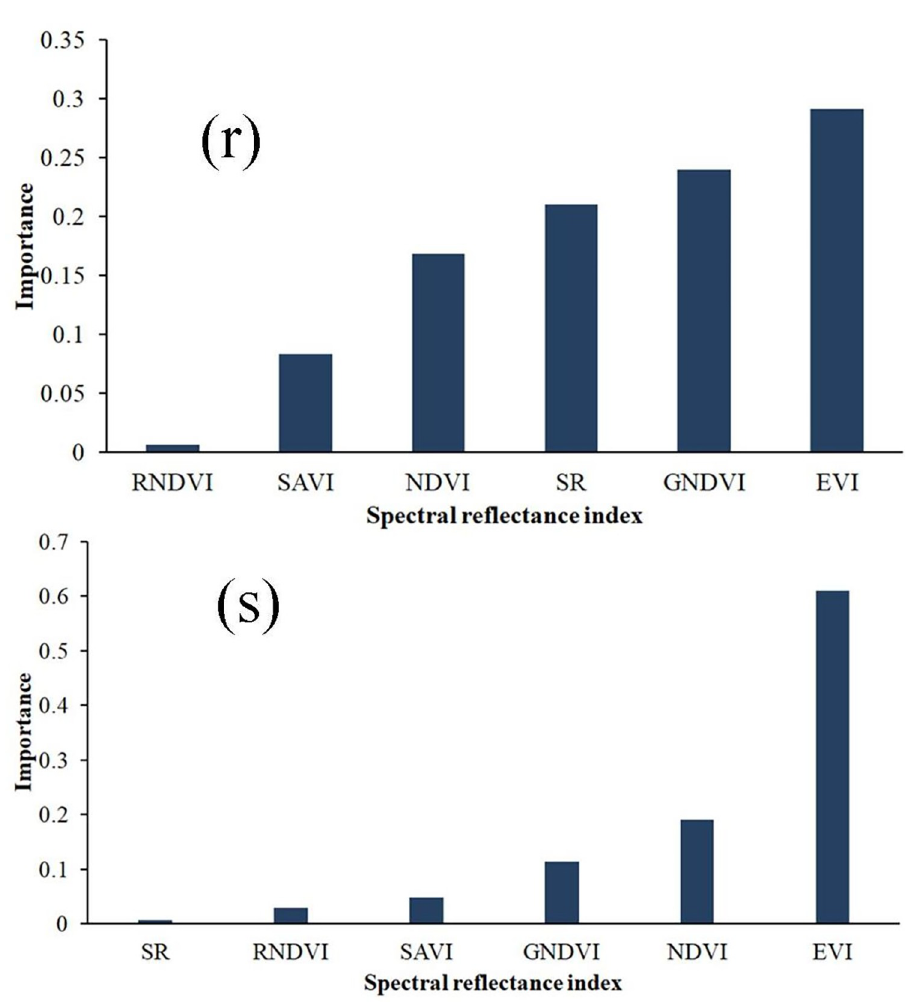
Fig 7. The predictors’ significance in the maize yield estimation. (r) The relative importance of the predictors for the grain yield and (s) The relative importance of the predictors for the aboveground biomass; EVI, enhanced vegetation index; NDVI, normalized difference vegetation index; RNDVI, red normalized difference vegetation index; SAVI, soil adjusted vegetation index; WI, water index; GNDVI, green normalized difference vegetation index; and SR, simple